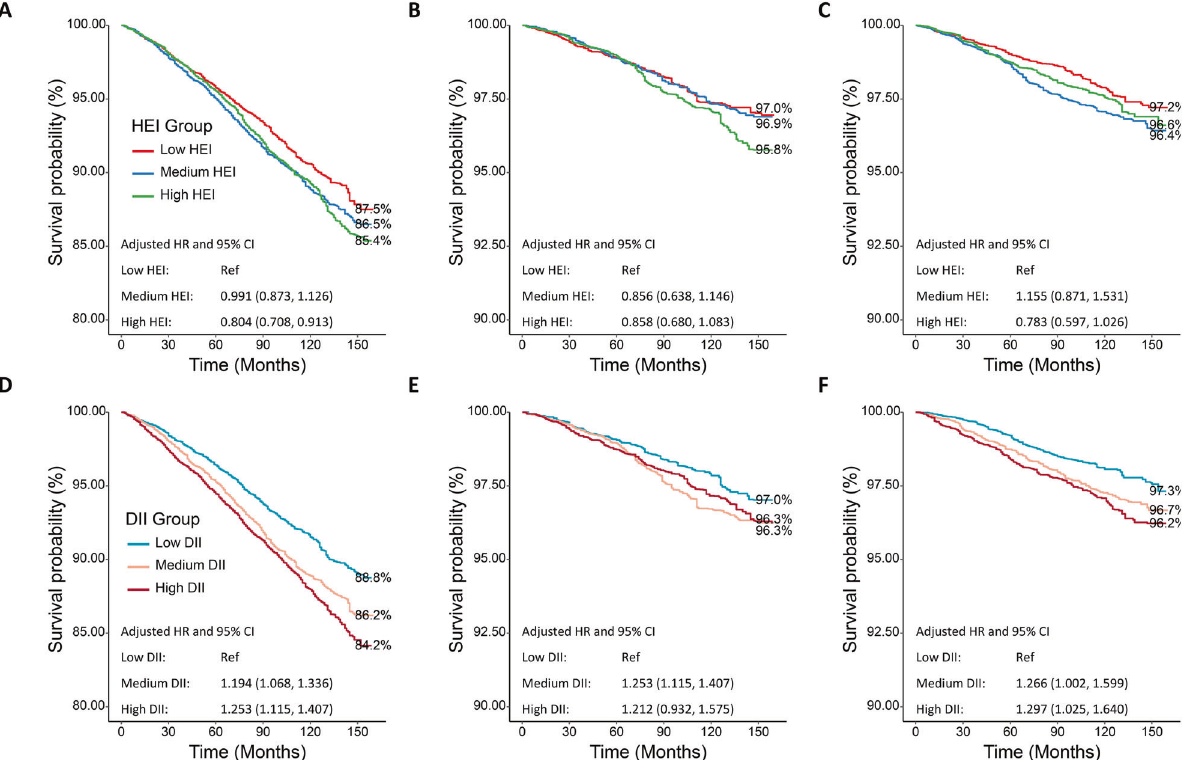
Fig. 3 Association between dietary patterns and long-term mortality. A Association between HEI and all-cause mortality; B Association between HEI and death of malignant neoplasms; C Association between HEI and death of heart diseases; D Association between DII and all- cause mortality; E Association between DII and death of malignant neoplasms; F Association between DII and death of heart diseases. CI con fi dence interval, DII dietary in fl ammatory index, HEI healthy eating index; HR: hazard ratio.